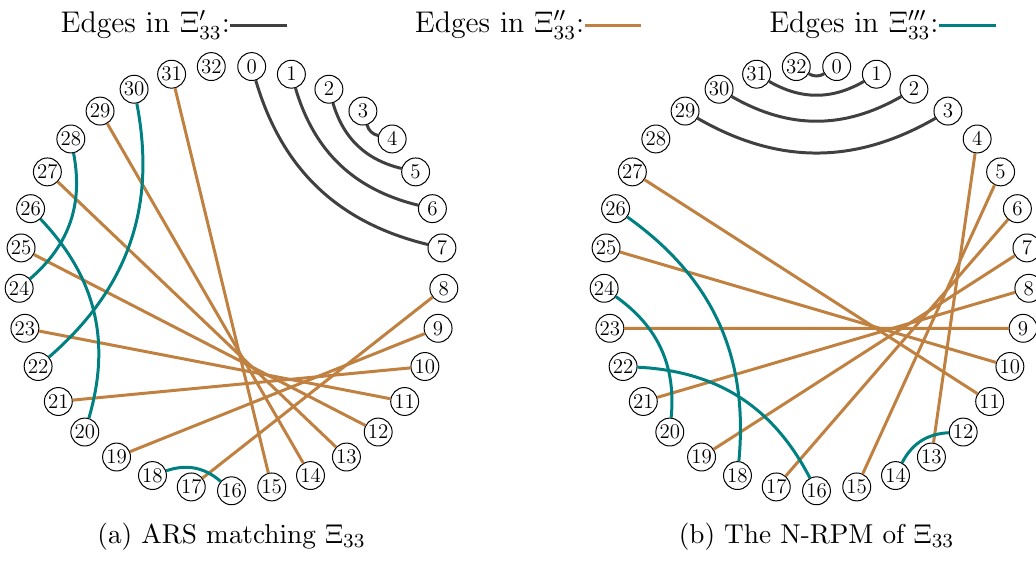
Figure 7: ARS matching Ξ